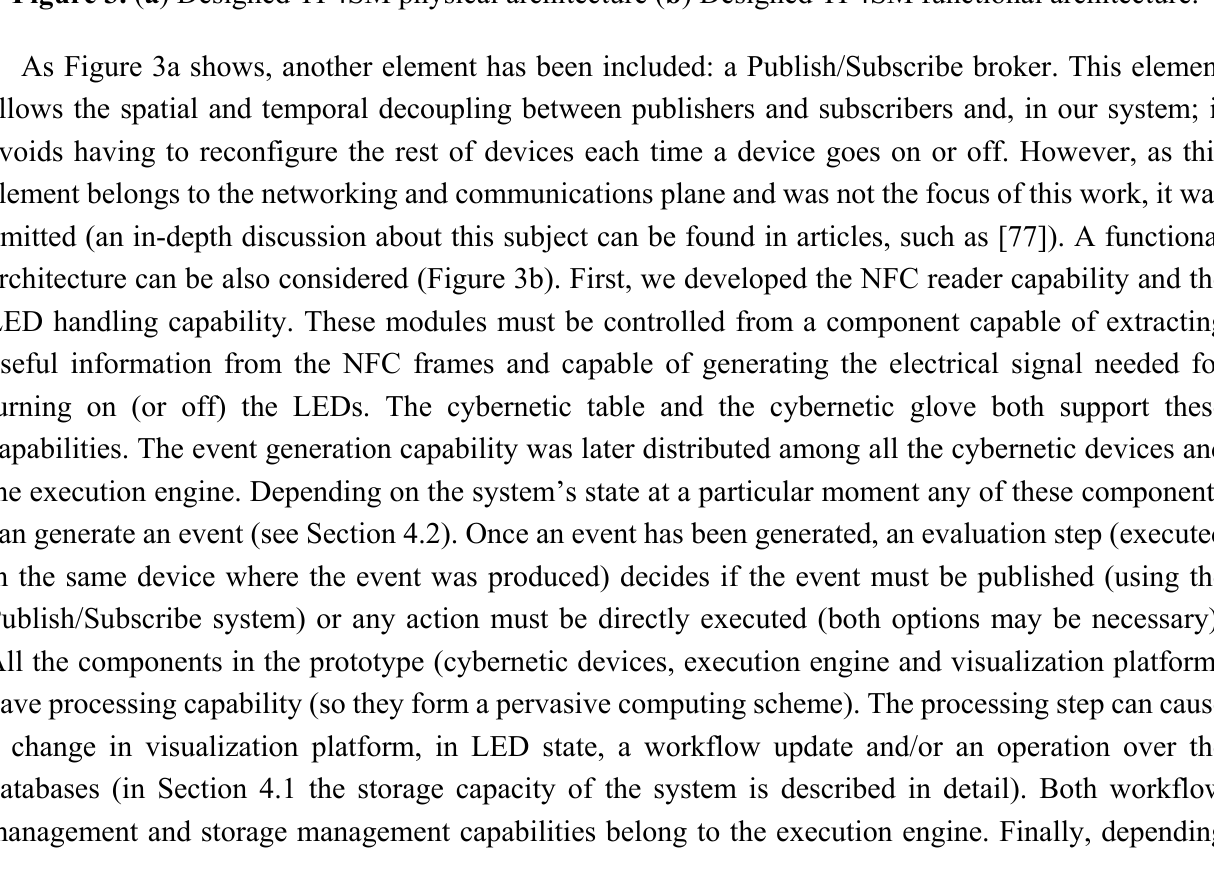
Figure 3. ( a ) Designed TF4SM physical architecture ( b ) Designed TF4SM functional